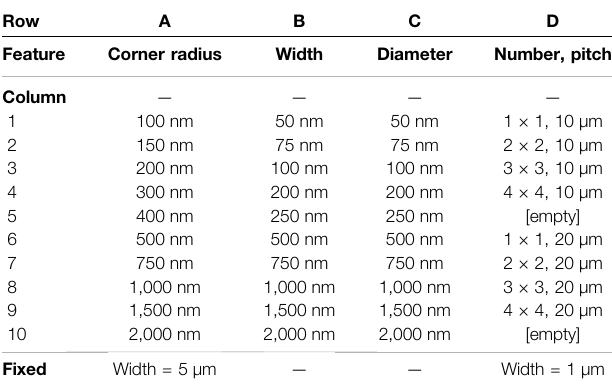
TABLE 1 | Sample design feature parameter